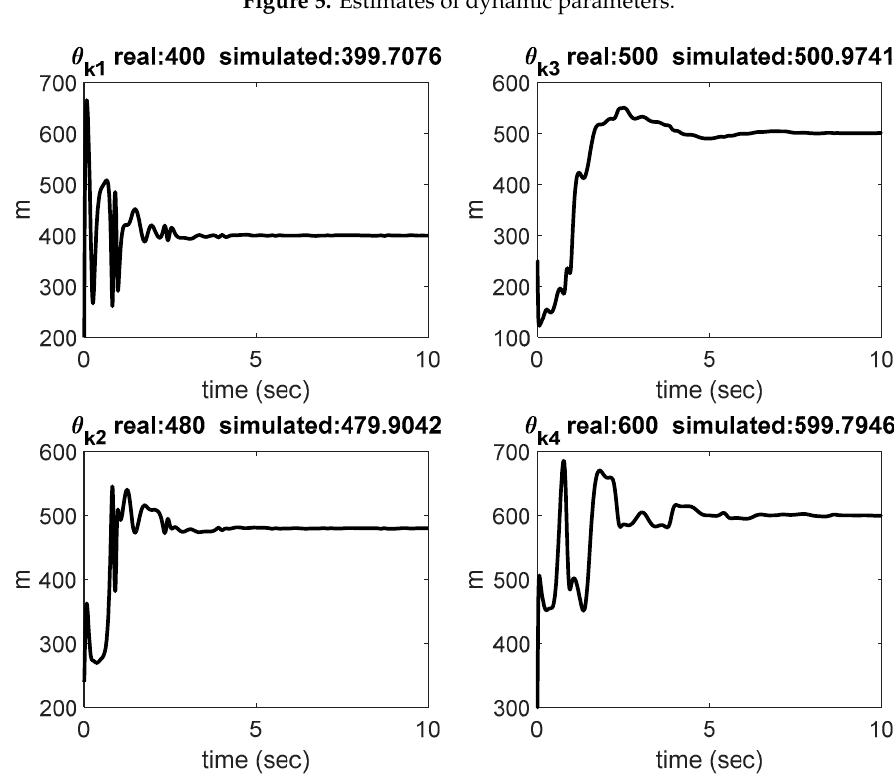
Figure 6. Estimation of kinematic parameters.